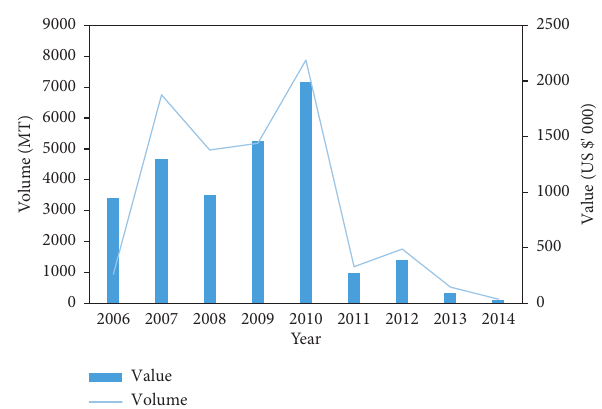
Figure 1: Volume and value of kola nut exports in Ghana. Source: Ministry of Food and Agriculture, 2015.